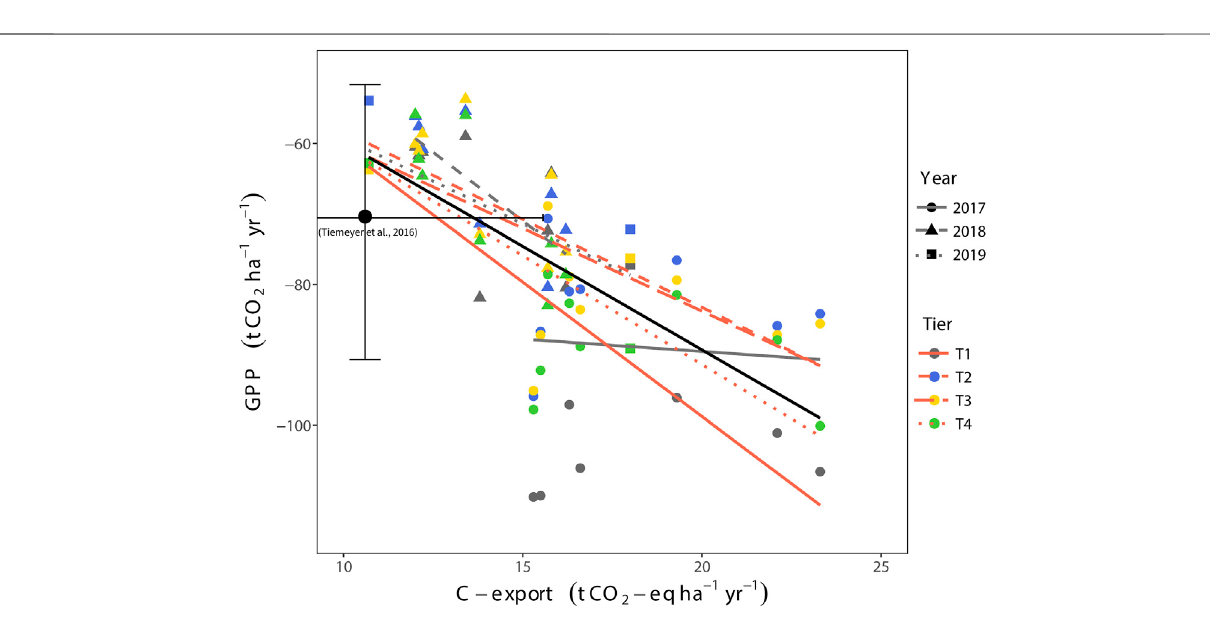
Frontiers in Environmental Science |